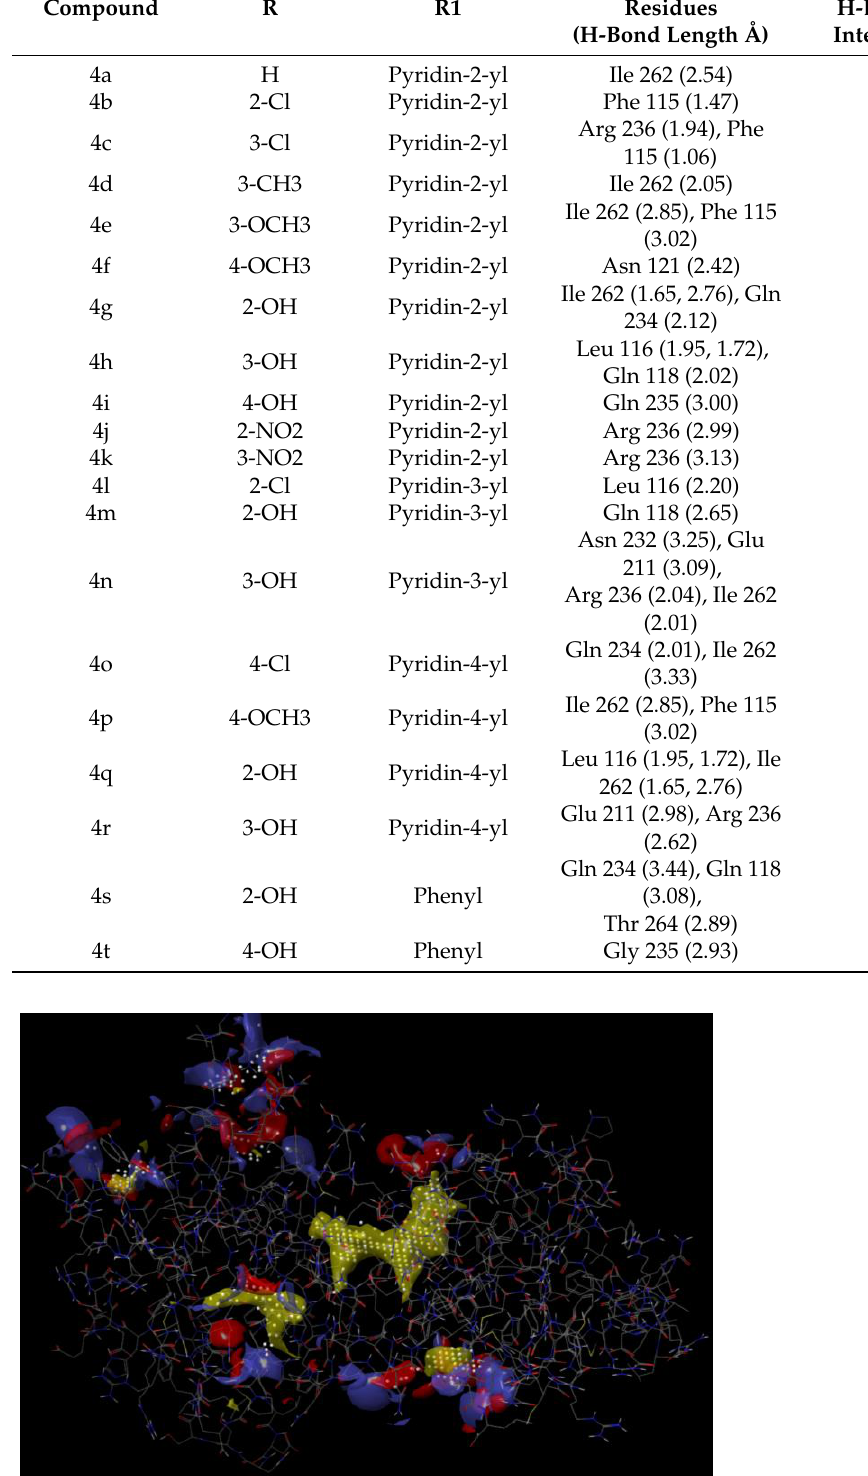
Figure 2. Detection of binding sites using Sitemap tool.